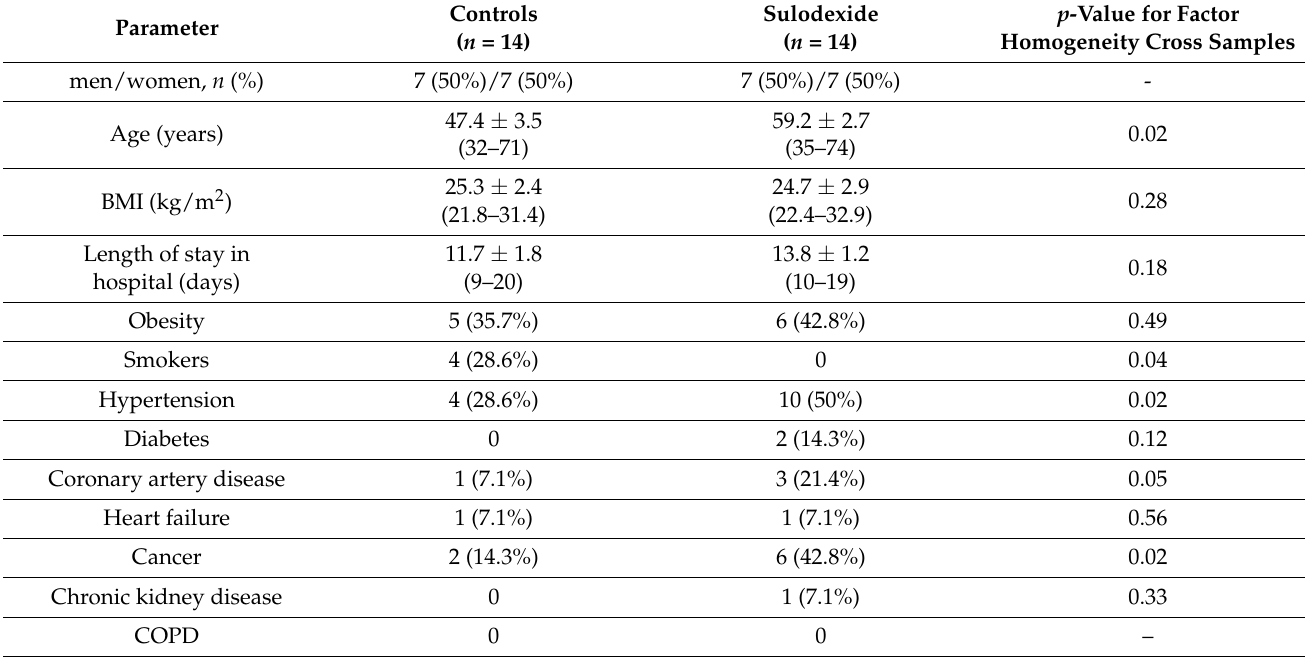
Table 1. Admission parameters of the patients.